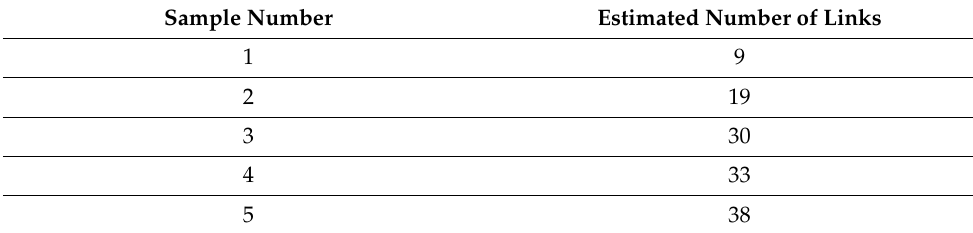
Table 4. Approximate number of units determined by NMR spectroscopy.